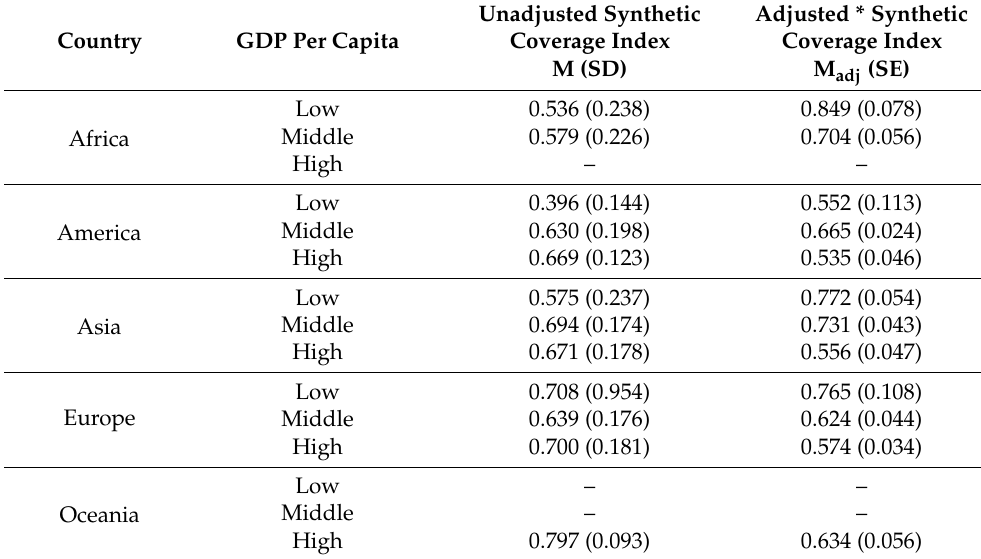
Table 3. Mean value (SD) of the synthetic coverage index unadjusted and adjusted for HDI. Two-way ANCOVA (IV: country e GDP per capita, covariates: